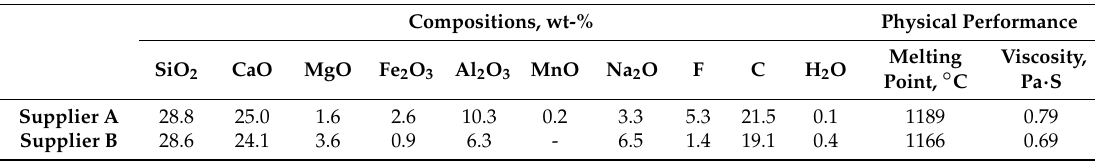
Table 4. Compositions and performance of mold flux.